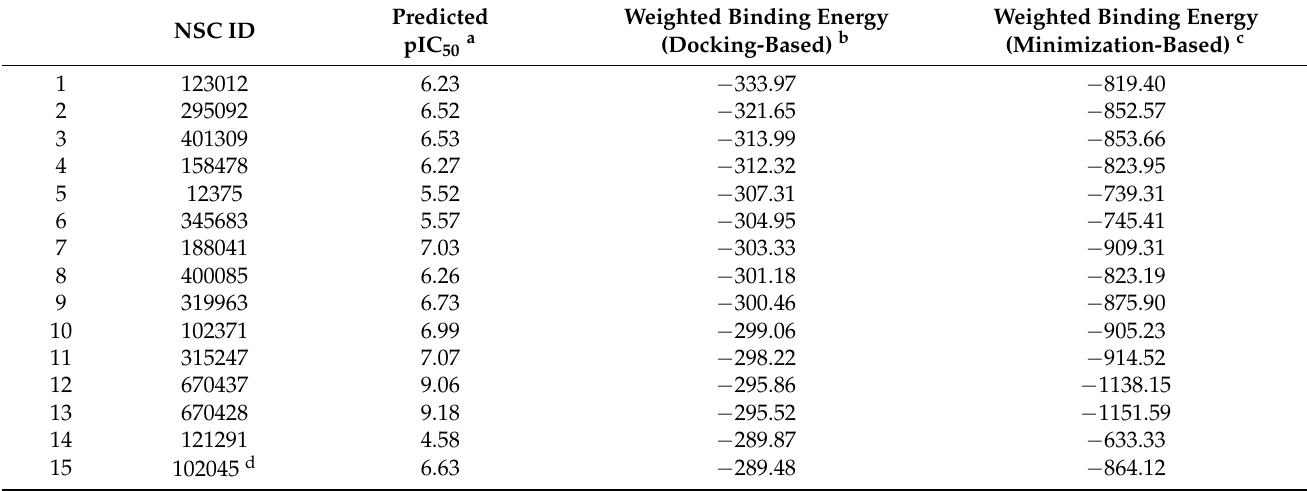
Table 3. Top 15 compounds selected in the combinatorial virtual screening.